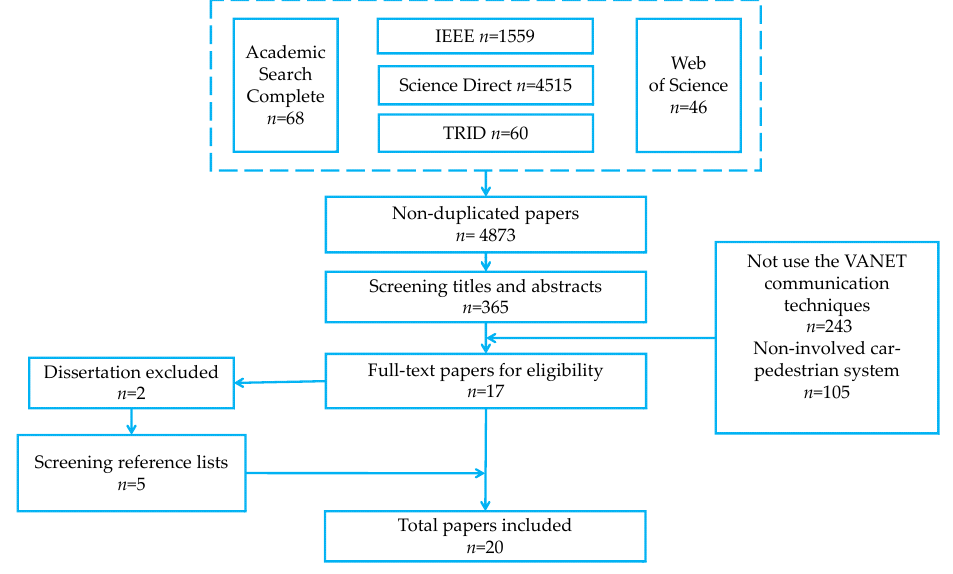
Figure 1. The flowchart of systematic review process.